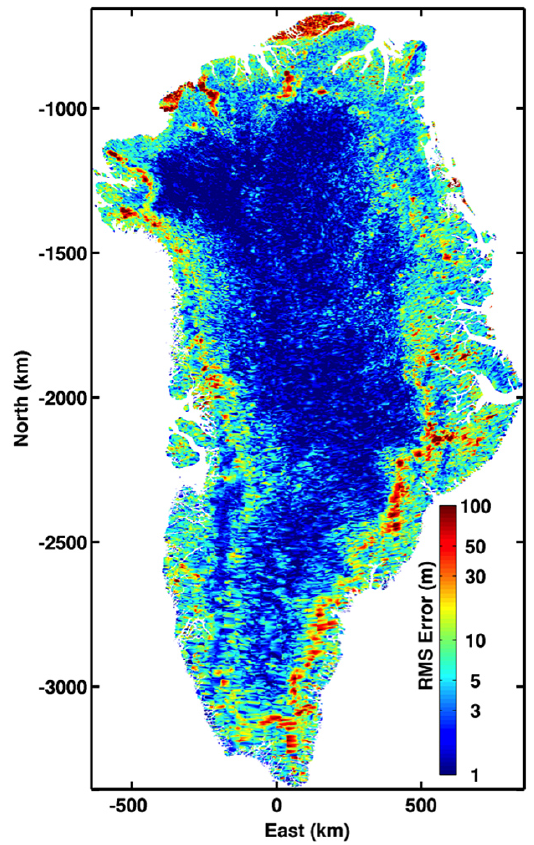
Figure 6. Map of the root mean square (RMS) of differences be- tween the GIMP DEM and ICESat elevations. Note the logarithmic color scale. Individual point differences along ICESat tracks are lin- early interpolated to a 1km by 1km map grid in polar stereographic